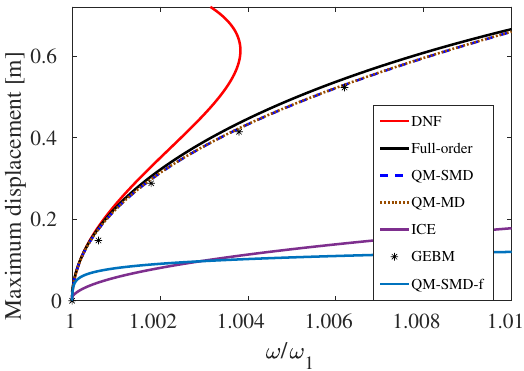
Figure 13. Backbone curves of the fundamental mode of the cantilever beam. Comparison of the reference solution (black) to the single-mode reduced dynamics given by the ICE method with fitting up to order 7 (purple), as those given by the DNF (red), QM–MD (dotted brown), QM–SMD (dashed blue), and QM–SMD-f (solid blue) methods. Black stars: reference solution obtained with the geometrically exact beam model (GEBM) taken from Figure 8 of